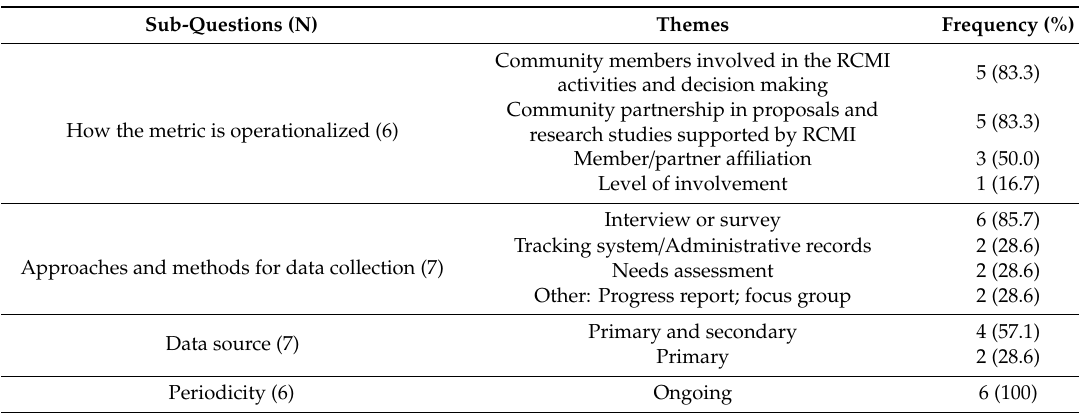
Table 7. Primary target: Increase scientific collaborations. Key findings of the case study regarding the operationalization and data collection strategies for the metric “number of partnerships with community partners and the